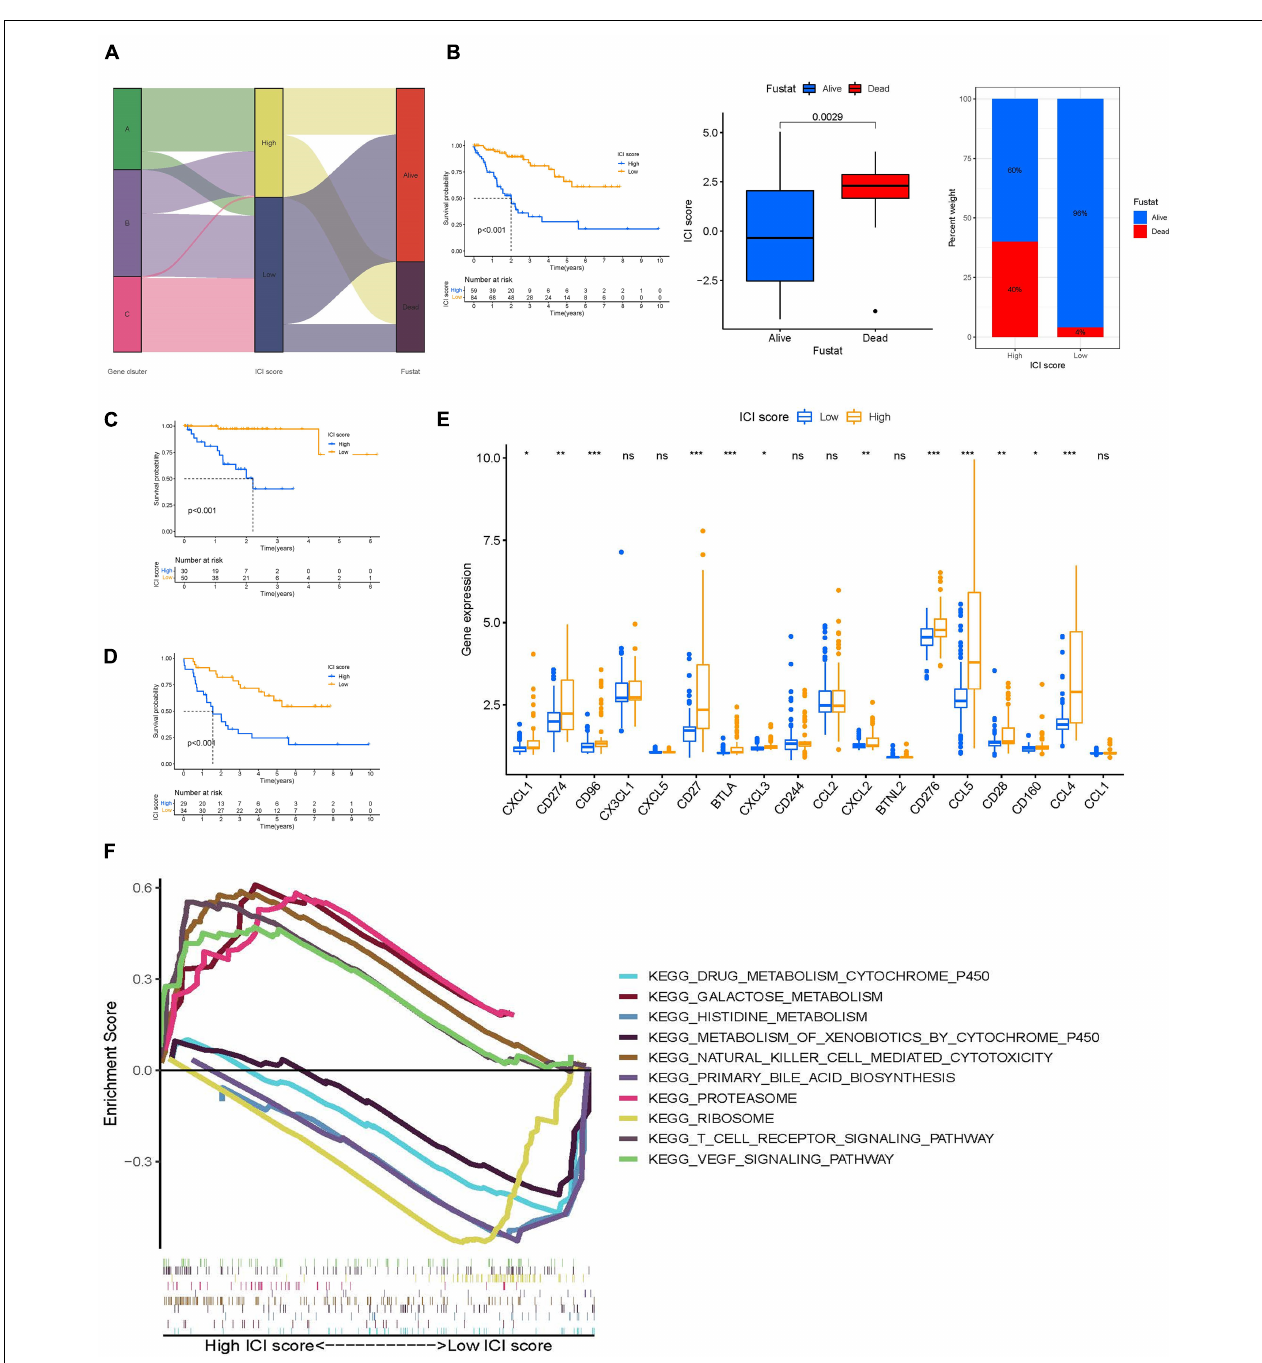
FIGURE 6 | Construction of ICI scores. (A) Alluvial diagram of ICI gene clusters in groups with different ICI clusters, ICI scores, and survival outcomes. (B) Kaplan–Meier curves for the high- and low-ICI scores of UVM patients in TCGA-UVM and GSE22138 cohorts. Log-rank test shows overall p < 0.001. Distribution of ICI scores in different survival status in UVM ( p = 0.029). Rate of in high- and low-ICI score subgroups in UVM. (C,D) Kaplan–Meier curves for the high- and low-ICI scores of UVM patients in TCGA-UVM (C) and GSE22138 cohorts (D) . Log-rank test shows overall p < 0.001. (E) The expression level of immunoinhibitory signatures genes (BTLA, CD160, CD244, CD274, and CD96), immunostimulatory signatures genes (BTNL2, C10orf54, CD27, CD276, and CD28), and chemokine signatures genes (CCL1, CCL2, CCL3, CCL4, CCL5, CX3CL1, CXCL1, CXCL2, CXCL3, and CXCL5) in the high- and low-ICI score subgroup. ns, not significant; * p < 0.05; ** p < 0.01; and *** p < 0.001. (F) Enriched gene sets annotated by KEGG collection between the high- and low-ICI score subgroup. ICI, immune cell infiltration; UVM, uveal melanoma; OS, overall survival; KEGG, Kyoto encyclopedia of genes and genomes.